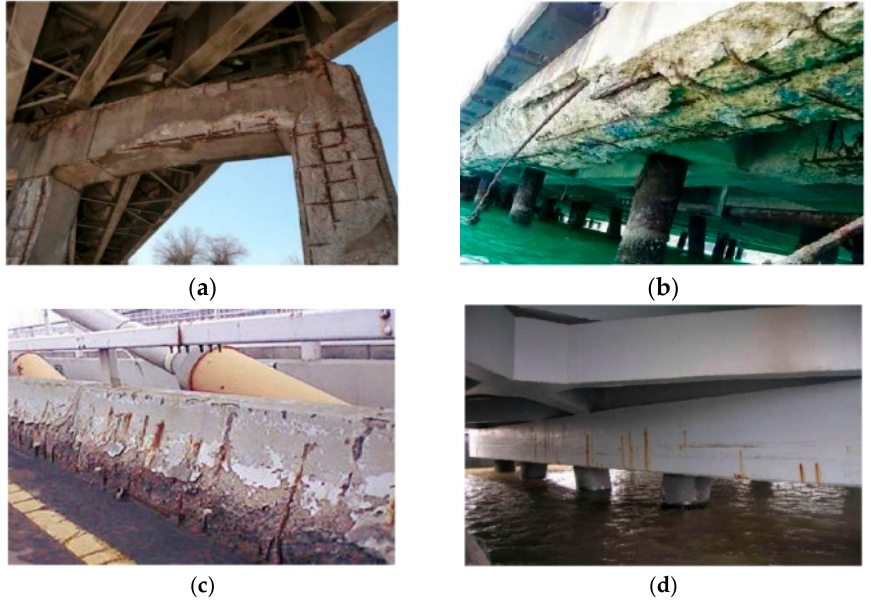
Figure 1. Corrosion of structures in a chloride environment. ( a ) Reinforcement corrosion of viaduct (reprinted with permission from L JR. 2021); ( b ) Rust of Qingdao Bridge (from LI T. 2022); ( c ) Diagram of rebar corrosion caused by deicing salt (from LI T. 2022); ( d ) Rust of Wuhan East Lake Bridge (from LI T. 2022).